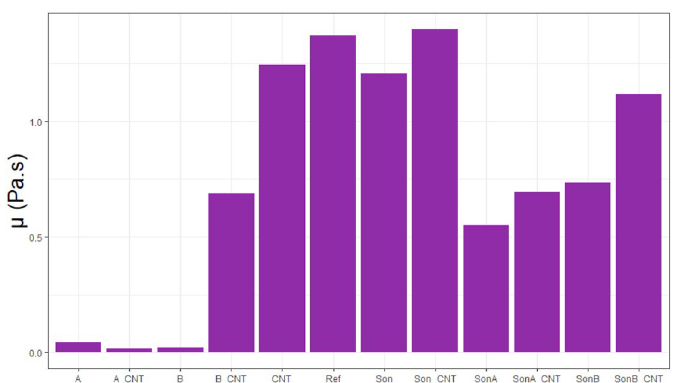
Figure 9. Apparent viscosity of the fresh Portland cement